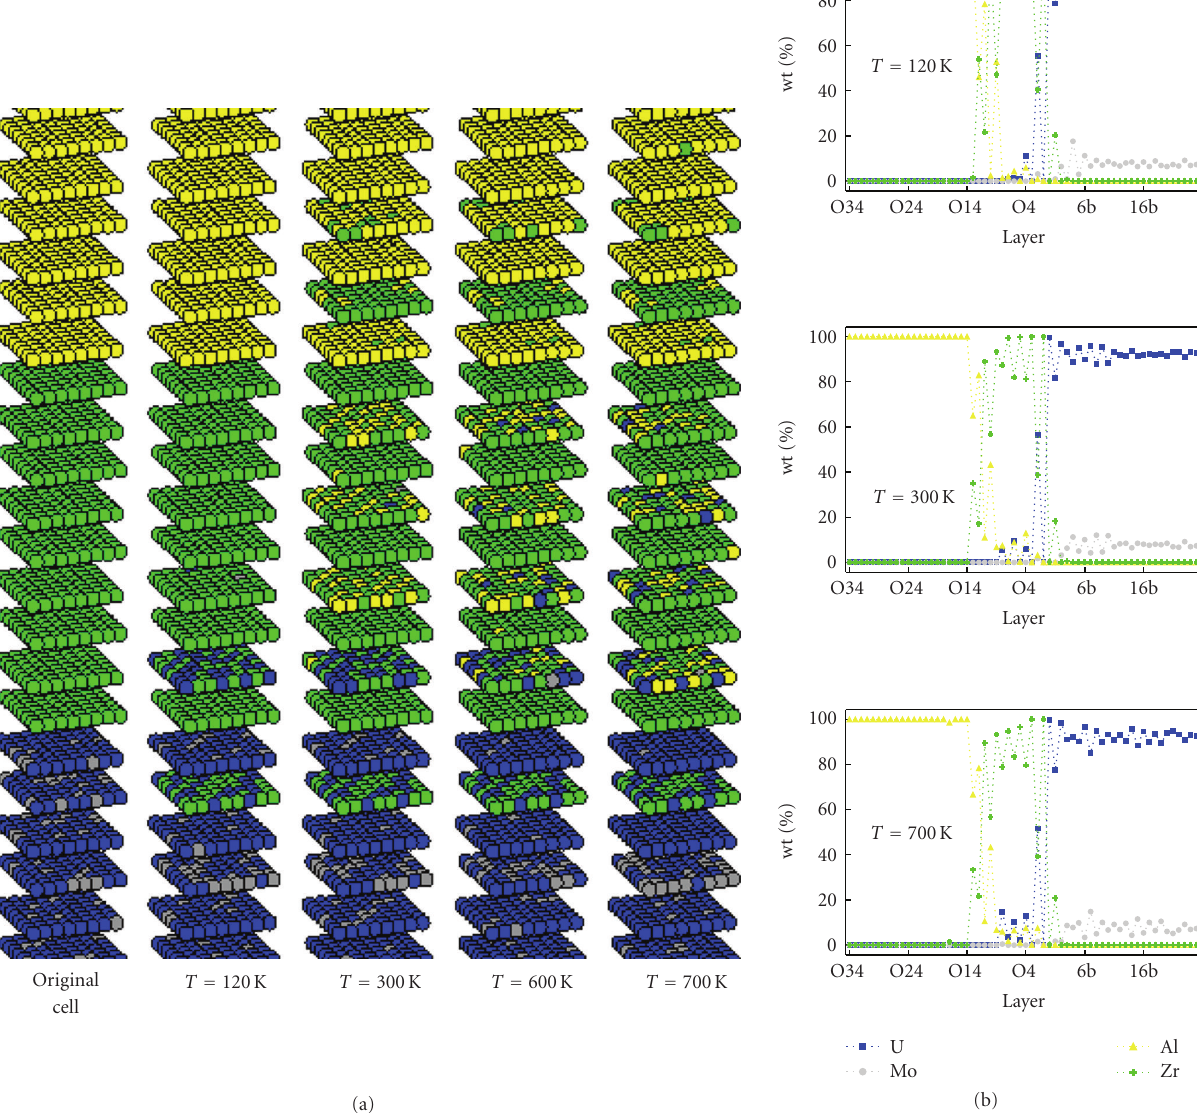
Figure 14: Intermediate states of a simulation of a computational cell with nine C planes in the Al/U-7wt% Mo interface. U, Mo, Al, and C atoms (and profiles) are denoted in blue, grey, yellow, and green, respectively. The original location of the interface (at the onset of the simulation) corresponds to the label